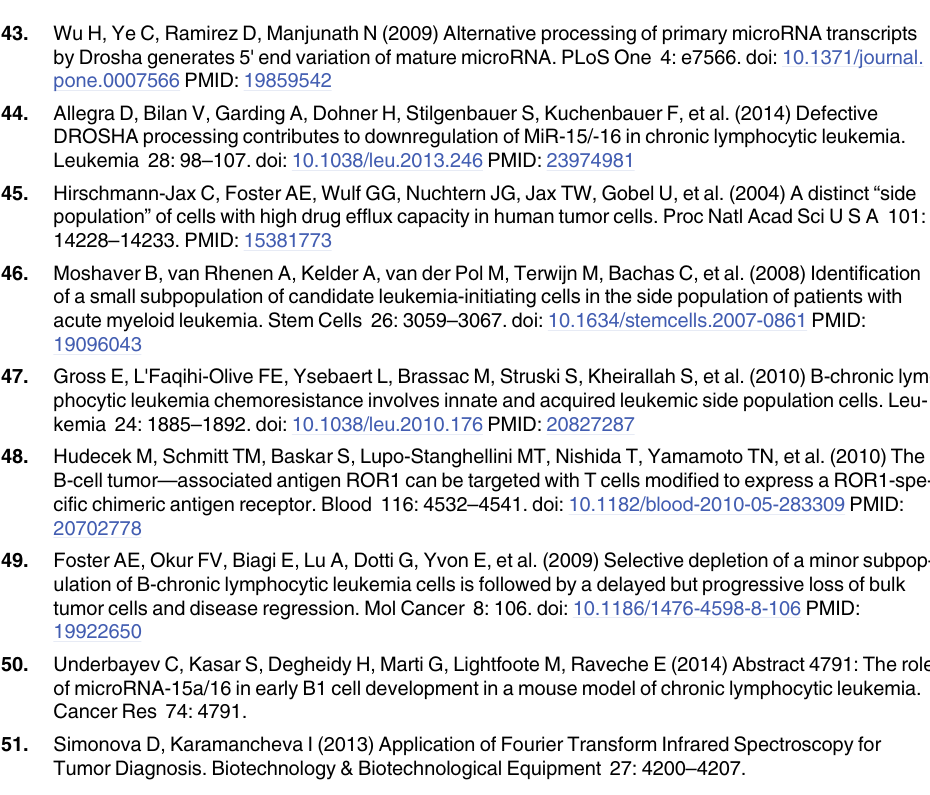
PLOS ONE | DOI:10.1371/journal.pone.0149331 March 9,